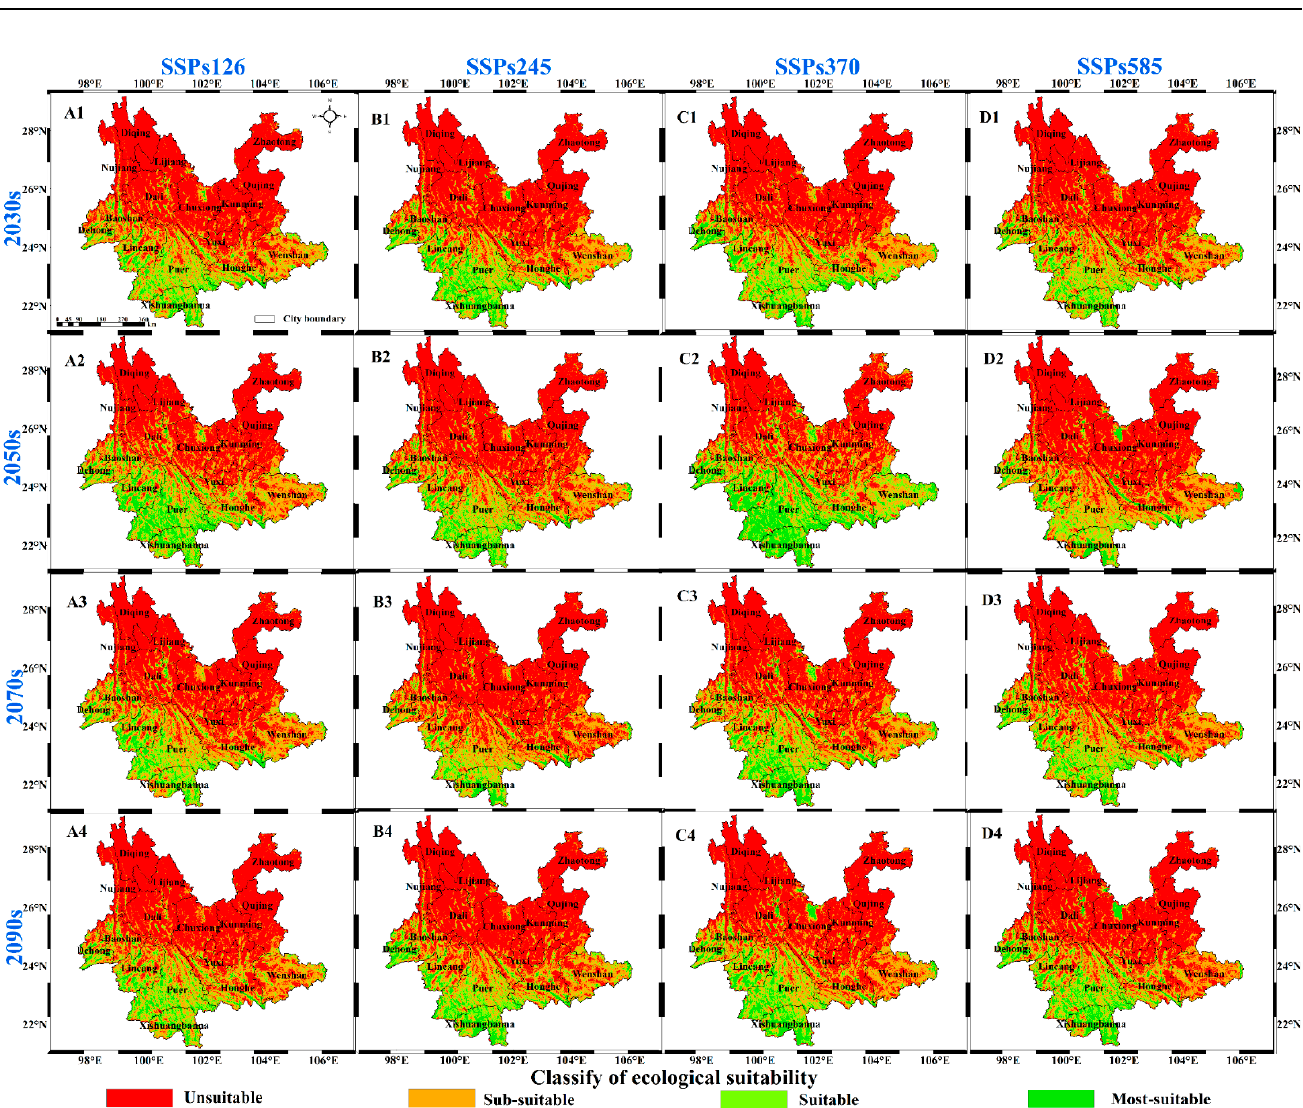
Figure 8. Map of the distribution of potentially ecologically suitable areas for Arabica coffee in Yun- nan under future scenarios . (( A1–A4 ) stands for SSPs126, ( B1 – B4 ) for SSPs245, ( C1 – C4 ) for SSPs370, and ( D1 – D4 ) for